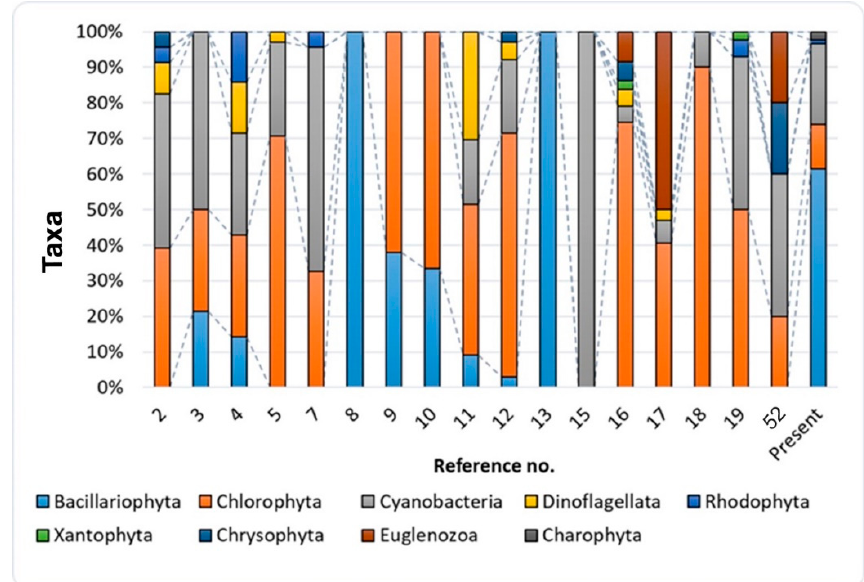
Figure 15. The percentage of the algae species richness in the Abraham Lincoln Birthplace National Historical Park in comparison to the other studied algal floras of Kentucky (Present). The numbers of the references are given on the horizontal axis.